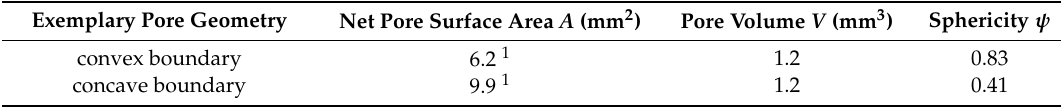
Table 1. Summary of the geometric descriptors for the generated pore geometries. Exemplary Pore Geometry